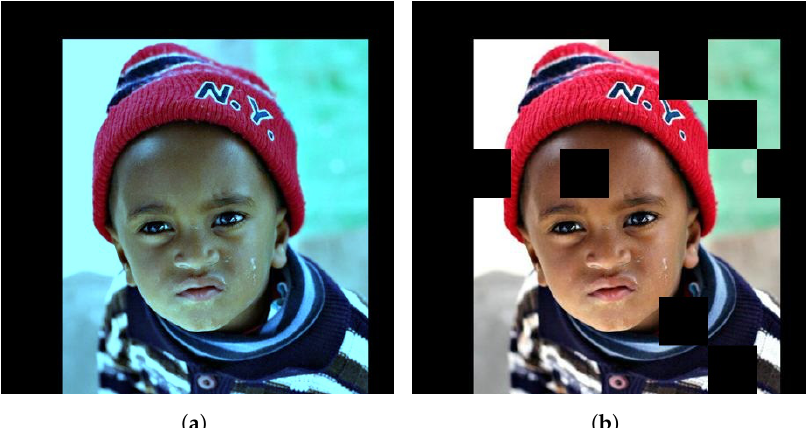
Figure 17. A subject from 300W-LP with different augmentations: ( a ) Colour channel scaling, ( b )